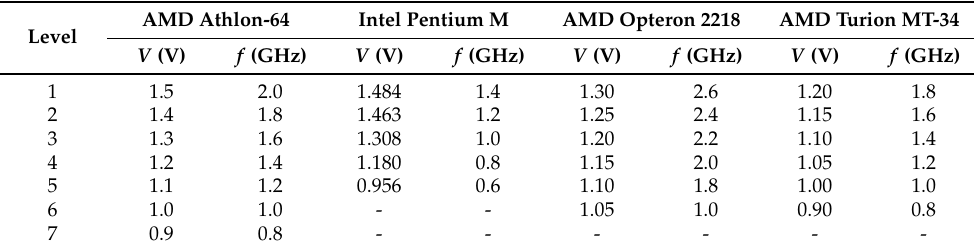
Table 1. The voltage/frequency pairs of four commodity processors.